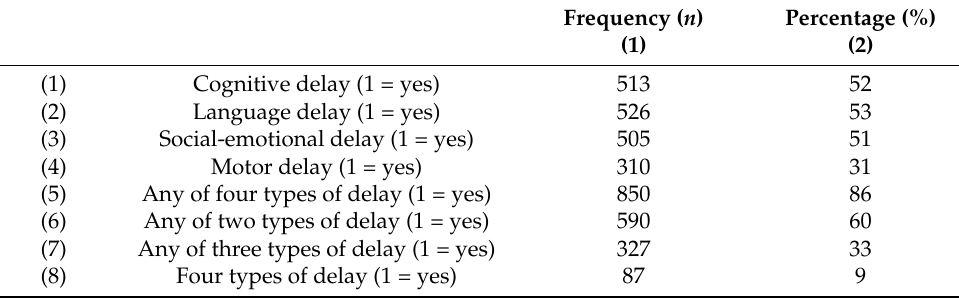
Table 5. Child development outcomes, n =